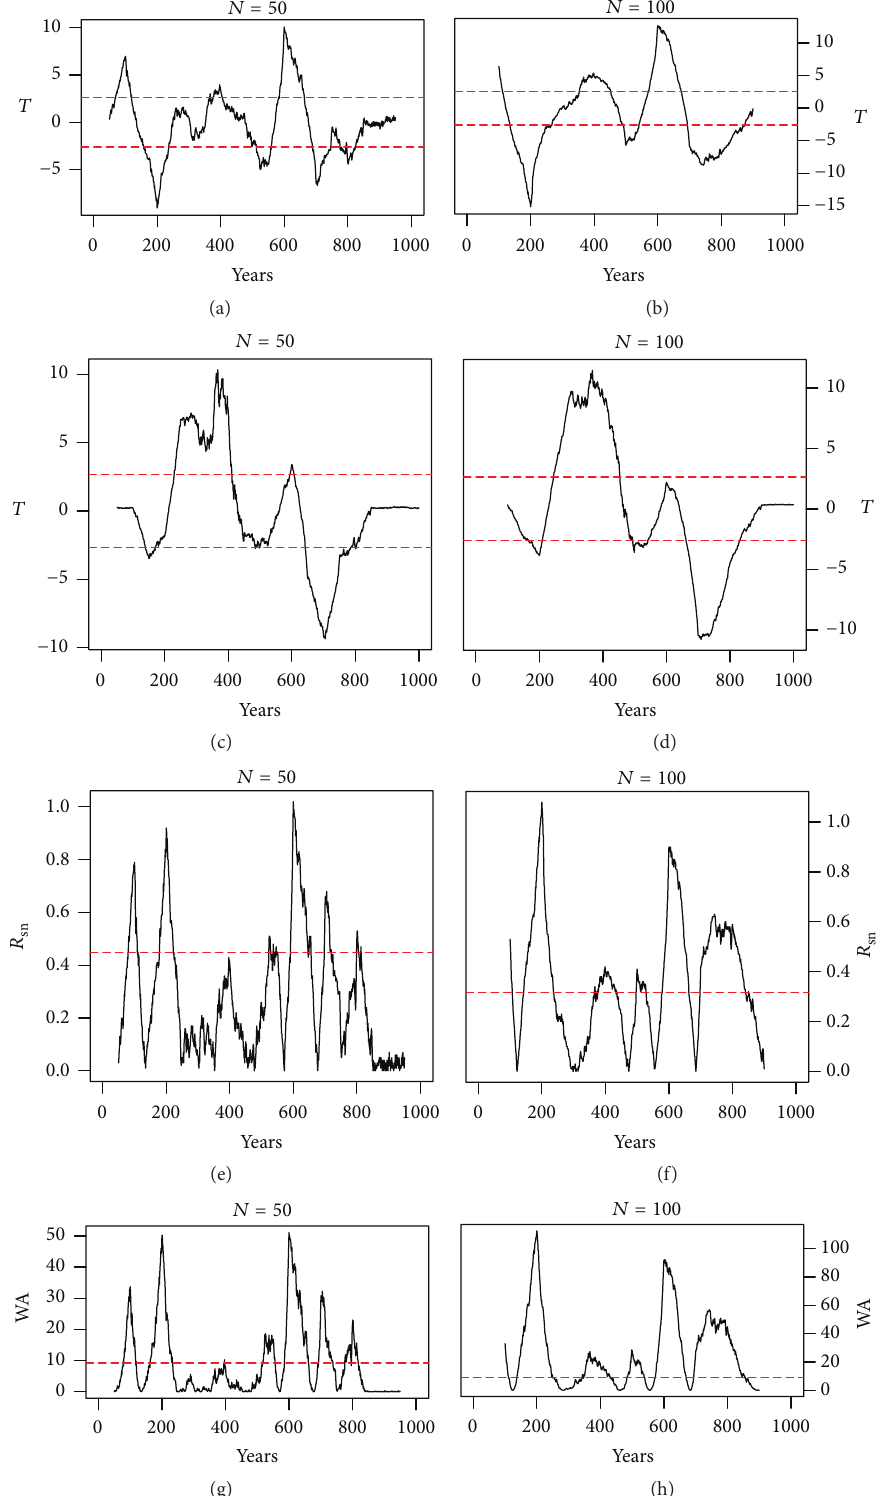
Figure 2: Abrupt changes detected by four different methods ((a) and (b), MTT; (c) and (d), CRA; (e) and (f), YAMA; (g) and (h), LP). Plots (a), (c), (e), and (g) have 𝑁 = 50 (the length of the subseries), and plots (b), (d), (f), and (h) have 𝑁 = 100 ; the red dashed lines indicate a significance level of 𝛼 = 0.01